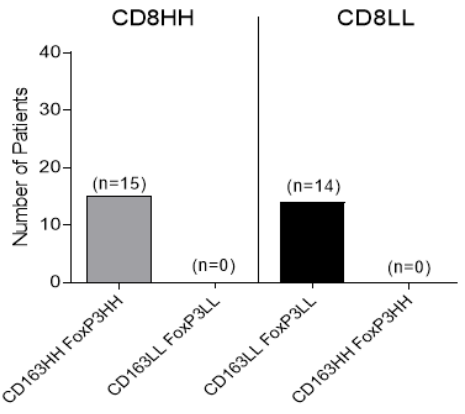
Figure 3. Association between CD8+ and combined CD163+, FoxP3+ cell densities in TC and IM. The number of patients with high densities of CD8+ cells (CD8HH) and densities of suppressive cell populations (CD163HH/FoxP3HH or CD163LL/FoxP3LL) are shown on the left panel. The number of patients with low densities of CD8+ cells (CD8LL) and densities of suppressive cell populations (CD163HH/FoxP3HH or CD163LL/FoxP3LL) are shown on the right panel.